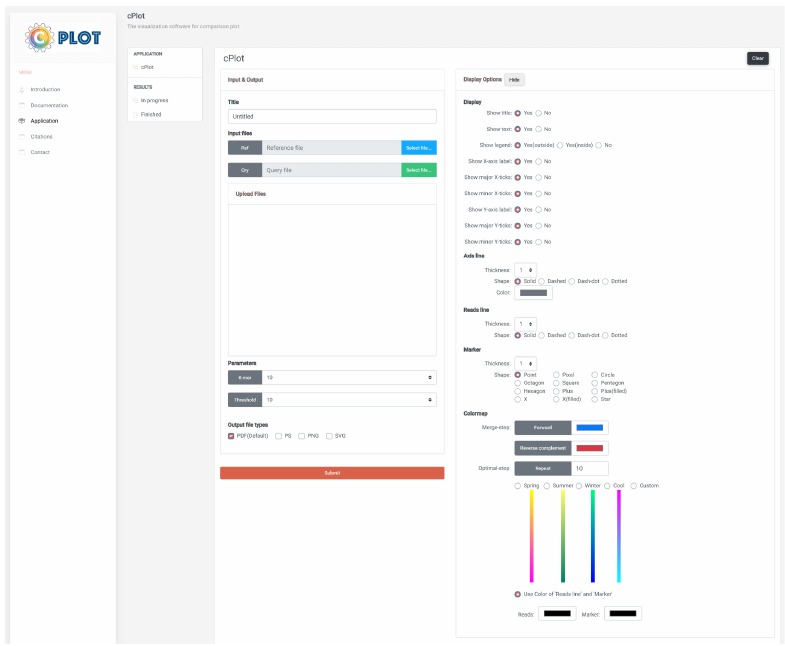
Figure 6. cPlot web